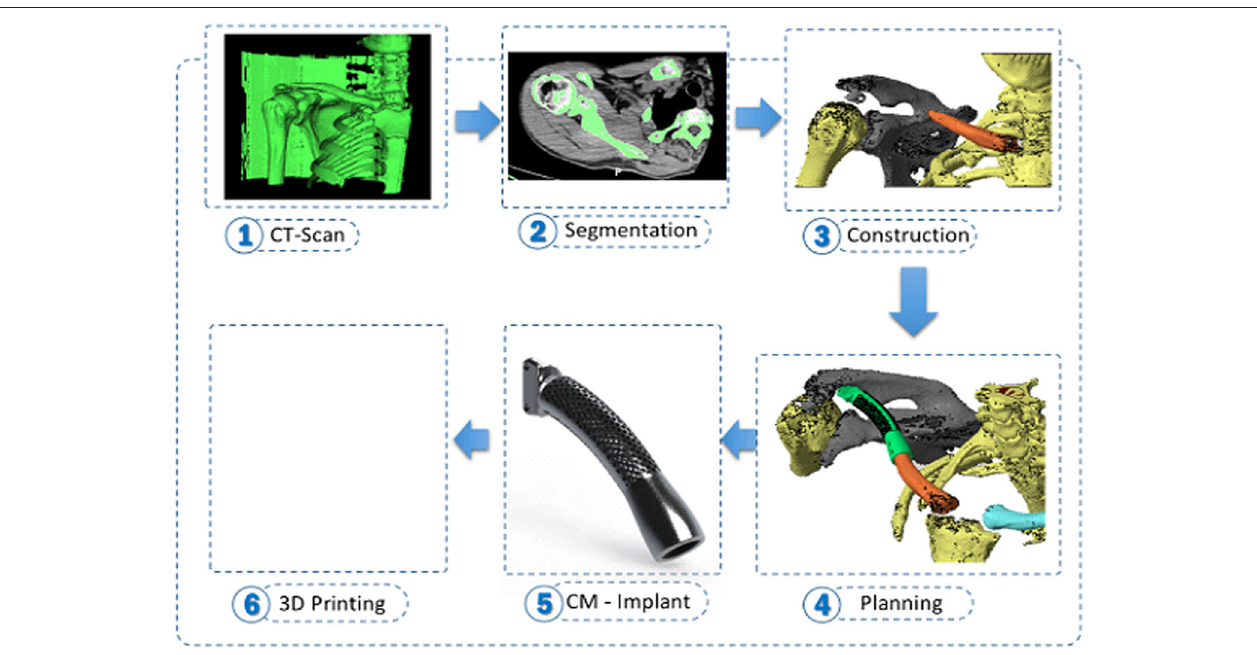
FIGURE 2 | The process of manufacturing of the prosthesis. The three-dimensional model of the clavicle was developed using the digital imaging and communication in medicine format, and image segmentation was performed using the Mimics software (Materialize NV).